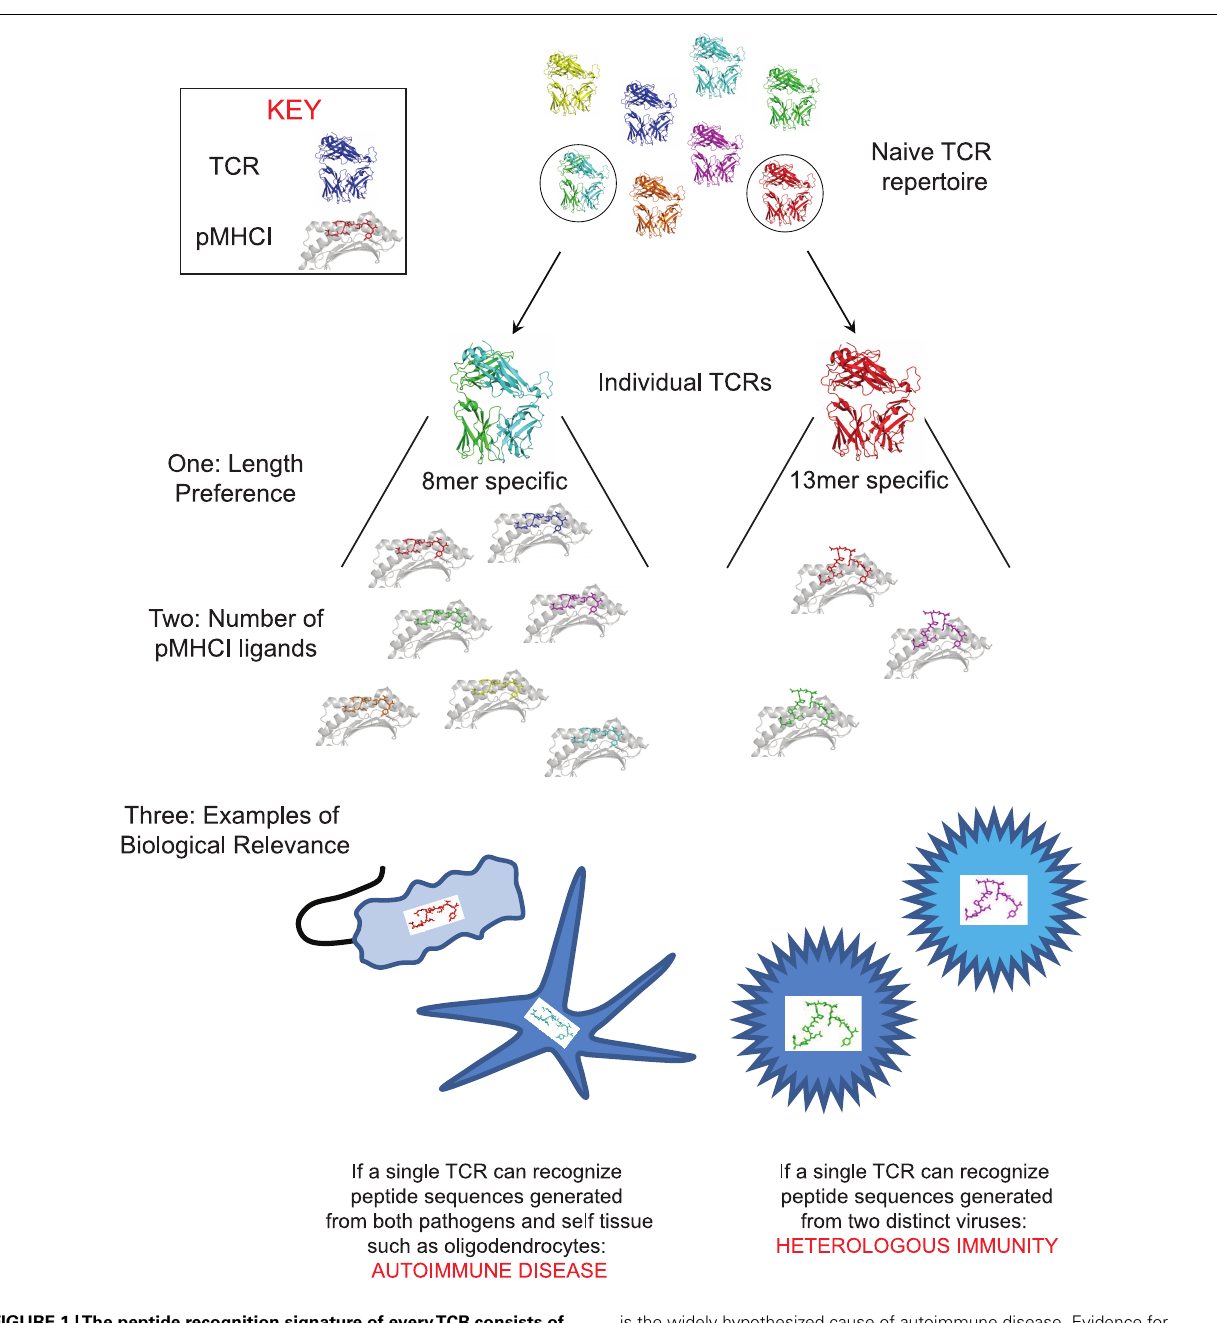
is the widely hypothesized cause of autoimmune disease. Evidence for this phenomenon exists in animal models of autoimmunity but convincing data in human disease is still lacking. By way of an example, the figure depicts the ability of the sameTCR to recognize peptide sequences generated from both environmental pathogens and oligodendrocytes. Alternatively, if aTCR can respond to naturally processed and presented peptide sequences from more than one pathogen then this will allow a singleTCR to provide immunity to more than one infection. It has been suggested that this phenomenon (often referred to as “heterologous immunity”) is extremely important for the provision of effective immunity. By way of an example, the figure depicts the ability of the sameTCR to recognize naturally processed and presented peptide sequences from two different